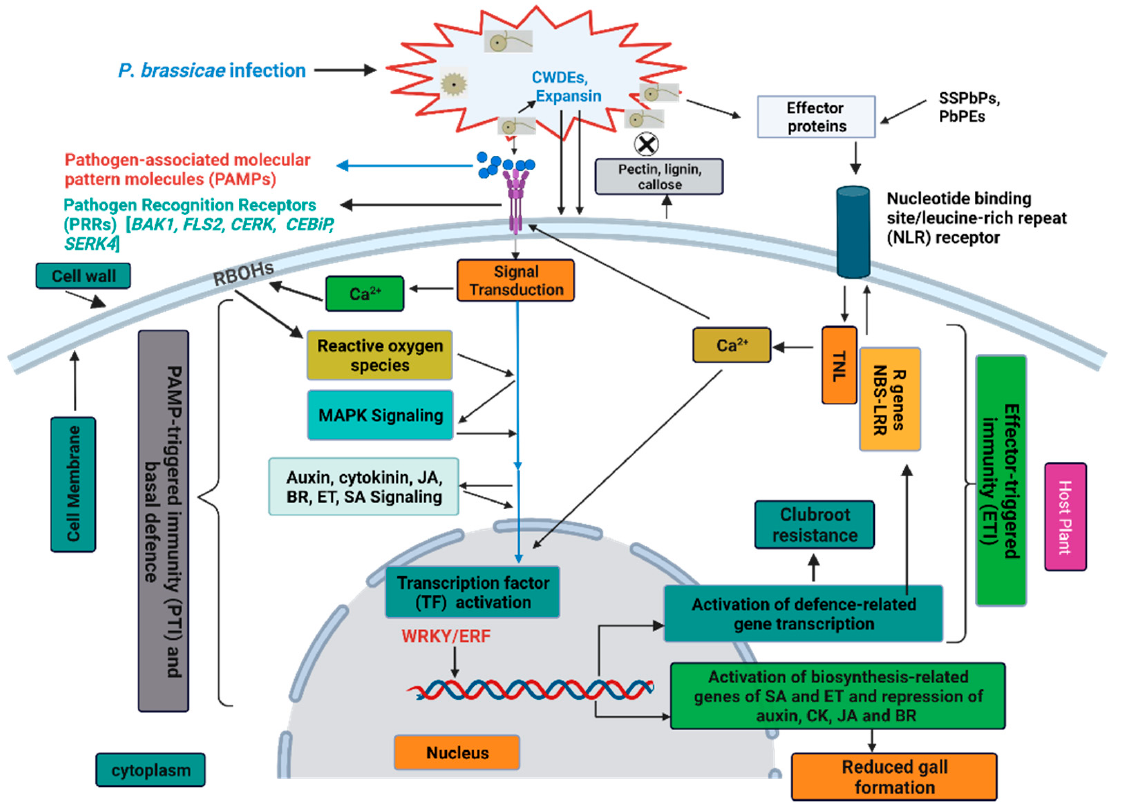
Figure 3. Proposed mechanism of clubroot resistance in Brassica crops.